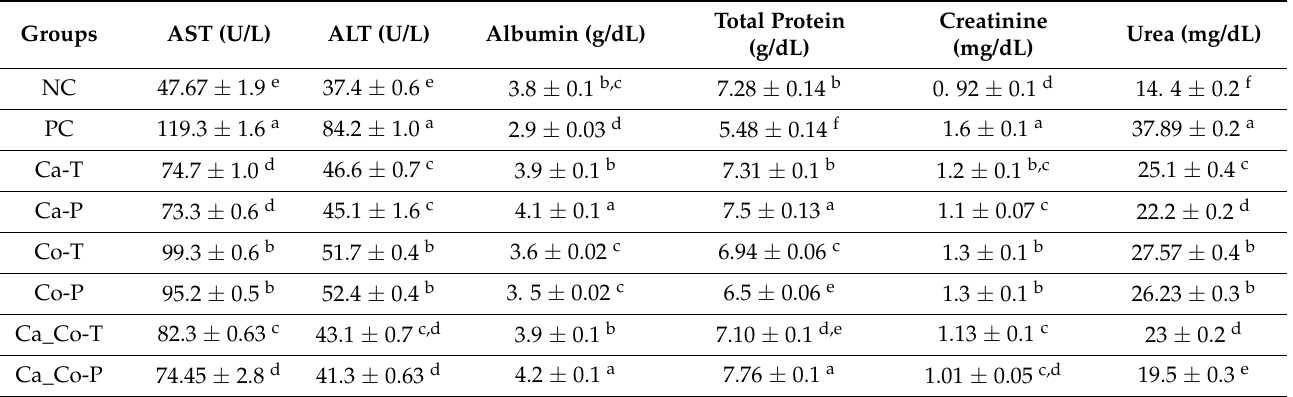
Table 5. Effect of different fermented milks on albumin, protein, serum enzyme activities of liver, and kidney markers in hypercholesterolemic